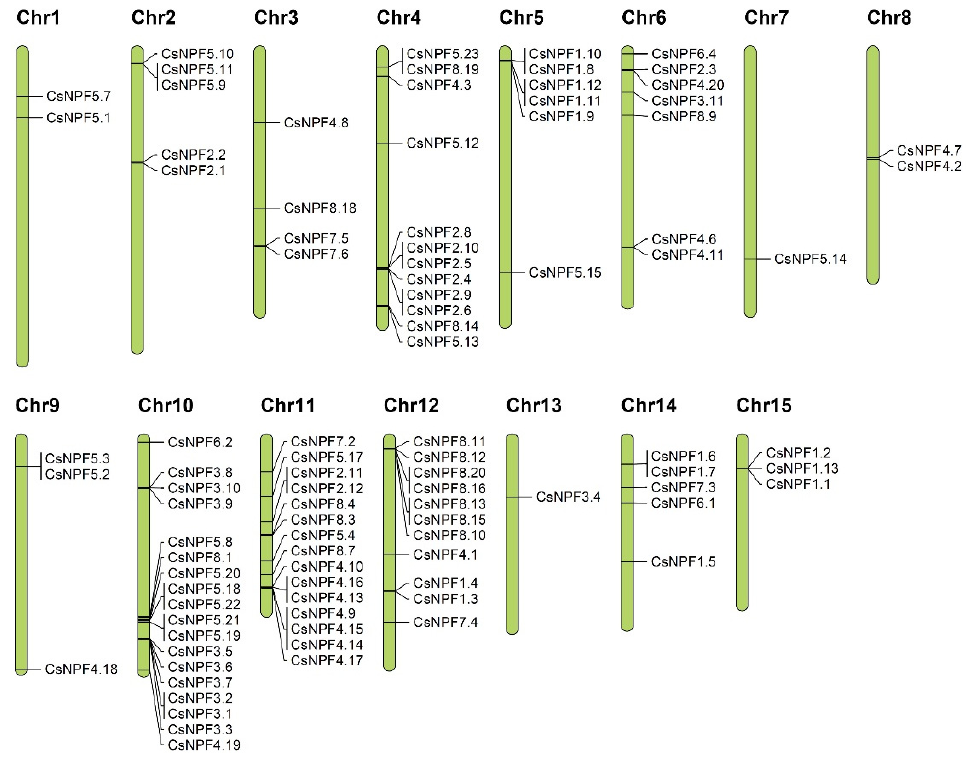
Figure 5. Chromosomal locations of CsNPF genes in tea plant genome.